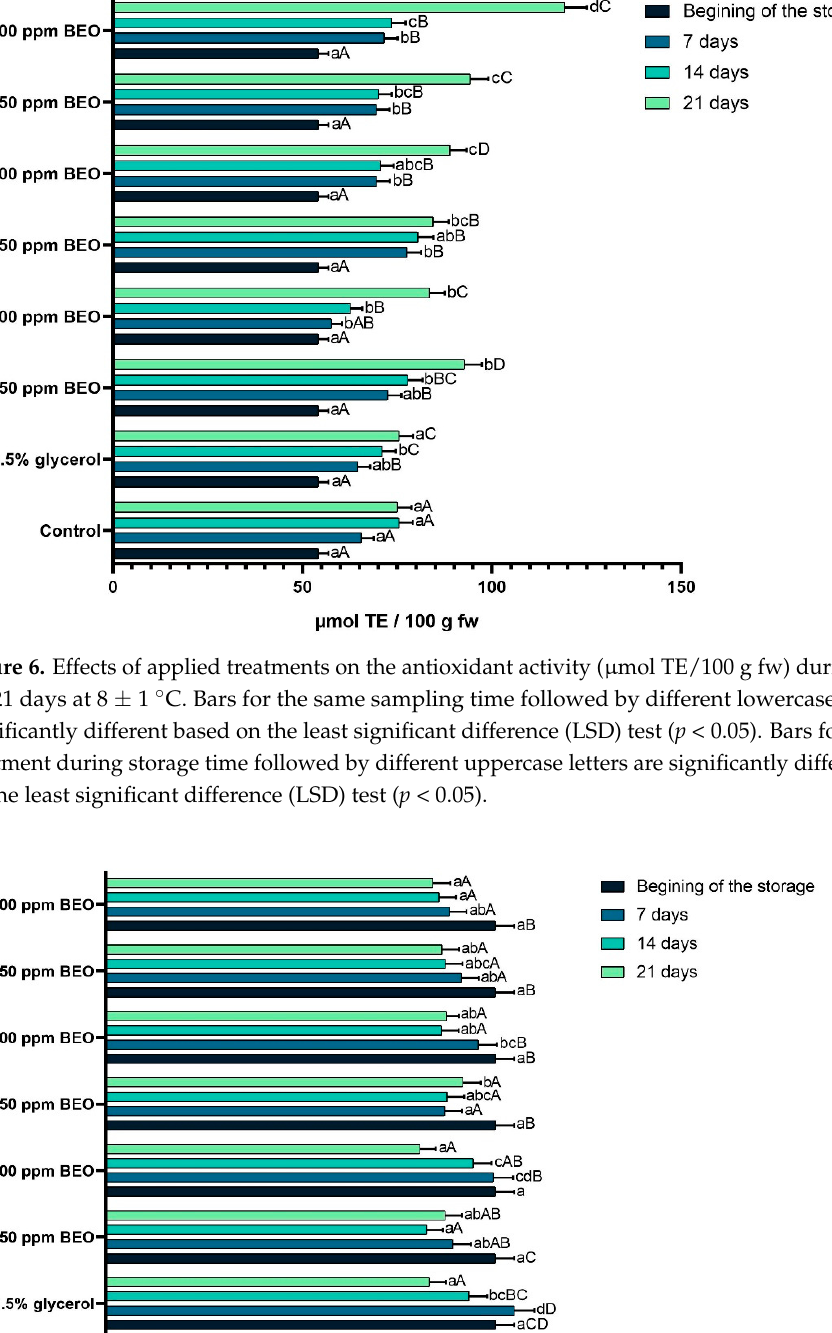
Figure 8. Effects of applied treatments on the Color index (fruit color parameter) during storage for 21 days at 8 ± 1 °C. Bars for the same sampling time followed by different lowercase letters are significantly different based on the least significant difference (LSD) test ( p < 0.05). Bars for the same treatment during storage time followed by different uppercase letters are significantly different based on the least significant difference (LSD) test ( p < 0.05).